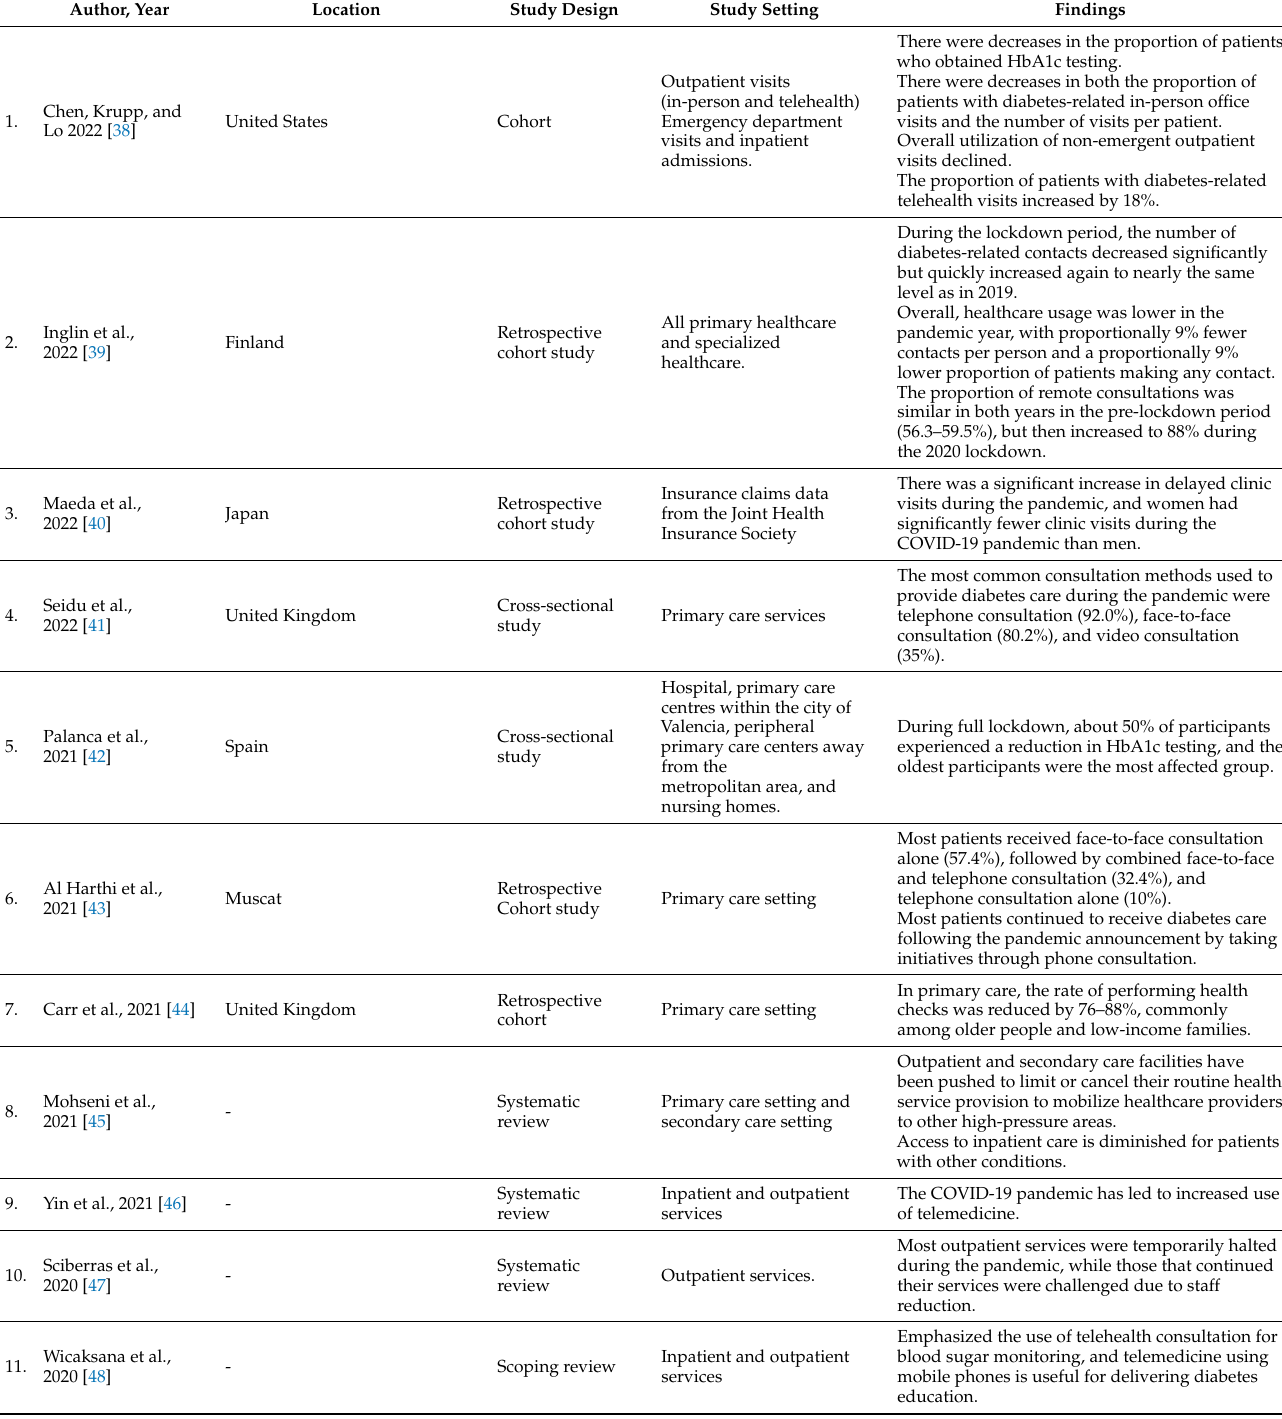
Table 2. Findings from the included